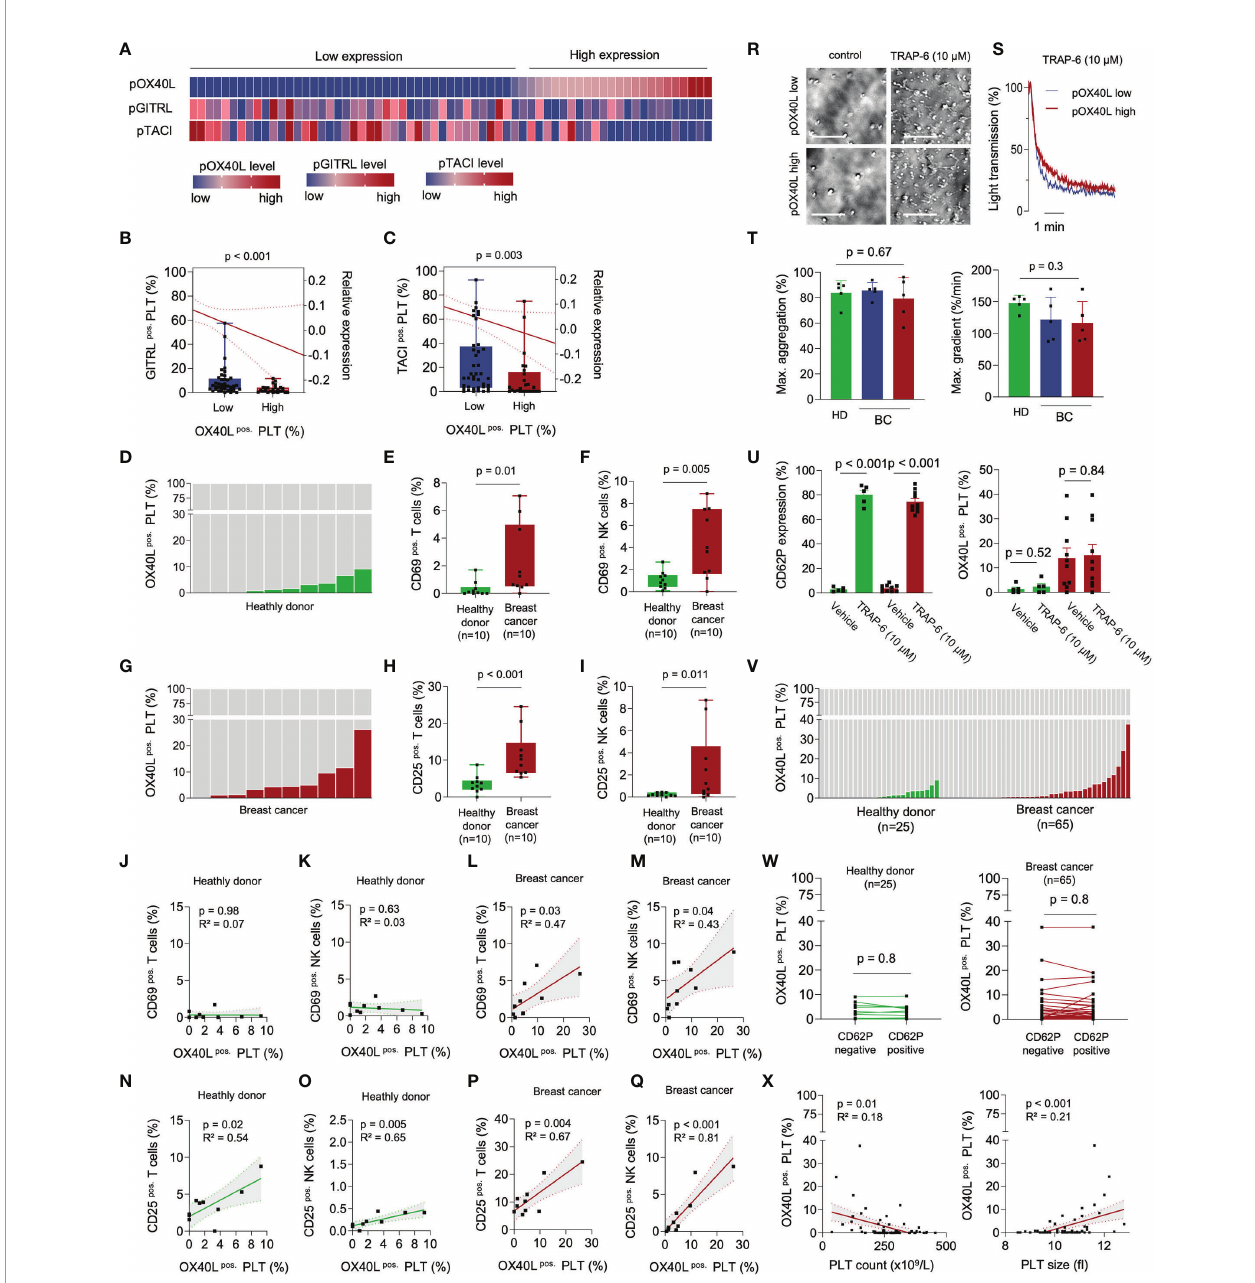
FIGURE 1 | pOX40L in breast cancer patients is associated with a distinct platelet immunophenotype and activation of cytotoxic lymphocytes. (A – C) Comparative analysis of the platelet immune checkpoint molecules pOX40L, pTACI and pGITRL (n = 65). The gating strategy used to analyze pOX40L expression on platelets is given in Supplementary Figure 3 . Co-expression of TACI (B) or GITRL (c) on pOX40L low and pOX40L high platelets, respectively. (D – J) Level of pOX40L in healthy donors (D) and breast cancer patients (G) and expression of CD69 (E, F) and CD25 (H, I) on NK cells and T cells of the respective donors (n = 10 each). (J – Q) Co- regulation of CD69/CD25 on NK/T cells and pOX40L in healthy donors and breast cancer patients (n = 10 each). r-t Comparative analysis of platelet activation in the presence or absence of TRAP-6 (10 µM) with regard to pOX40L status. Representative platelet aggregation studies (R, S) were performed in pOX40L high and low expressing platelets derived from breast cancer patients. Aggregation studies (T) were performed in platelets derived from 5 healthy donors (green) and 10 breast cancer patients (pOX40L low in blue, pOX40L high in red). (U) Expression of CD62P and OX40L on platelets from HD and breast cancer patients ex vivo (n = 10 each). (V) Expression of OX40L on platelets from healthy donors and the complete breast cancer cohort ex vivo (n = 25 and n = 65, respectively). (W) pOX40L level in healthy donors (HD), (left panel) and breast cancer patients (right panel) with regard to CD62P expression (n = 25 and n = 65, respectively). (X) Correlation of pTACI expression and platelet count (left panel) and platelet size (right panel). (B, C) , (E, F) , (H, I) Each dot represents a single patient. Boxes represent median and 25th to 75th percentiles, whiskers are minimum to